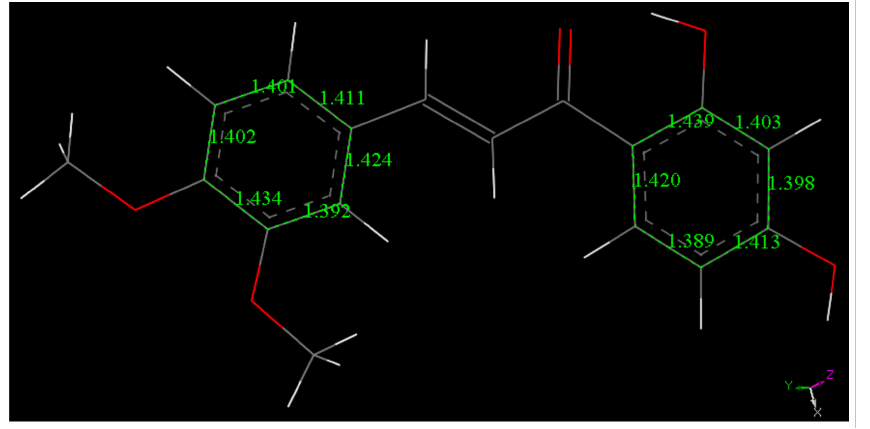
Figure 11. The chalcone ( 2 ), DHDM, minimum energy structure obtained after geometry minimiza- tion from initial X-ray coordinates.